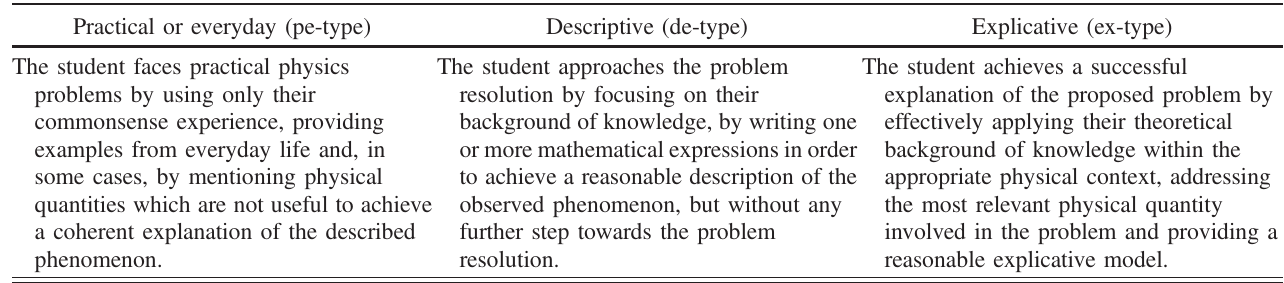
TABLE I. Summary of characteristics for the three student answering typologies reported in Ref. [23]. Practical or everyday